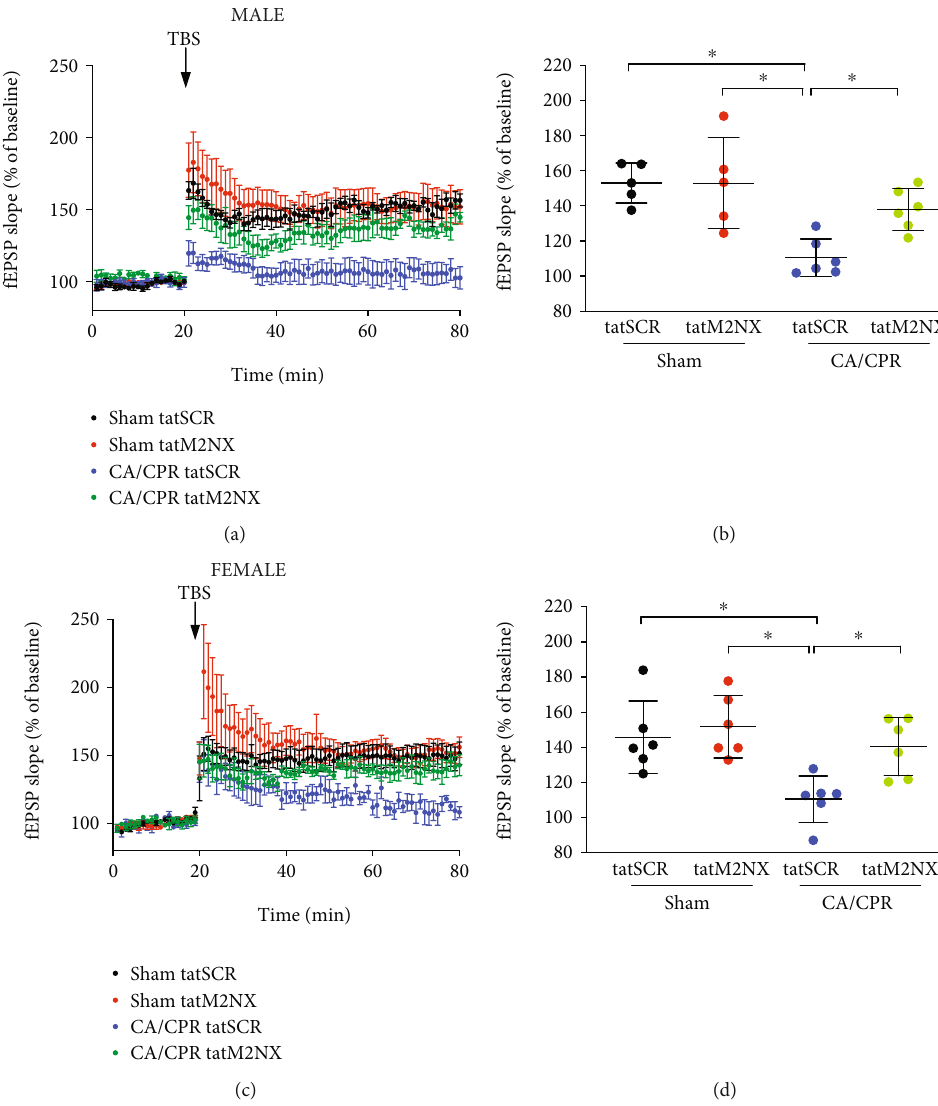
Figure 2: Acute inhibition of TRPM2 preserves LTP. (a) Time course of fEPSP slope from male juvenile mice 7 days after sham mice were administered 20mg/kg tatSCR (black) or tatM2NX (red) 30 minutes after CA/CPR and 7 days after CA/CPR mice were administered 20mg/kg tatSCR (blue) or tatM2NX (green) 30min after CA/CPR. (b) Quanti fi cation of change in fEPSP slope 60 minutes after TBS stimulation normalized to 20 minutes of baseline recording. (c) Time course of fEPSP slope from female juvenile mice 7 days after sham mice were administered 20 mg/kg tatSCR (black) or tatM2NX (red) 30 minutes after CA/CPR and 7 days after CA/CPR mice were administered 20mg/kg tatSCR (blue) or tatM2NX (green) 30 min after CA/CPR. (d) Quanti fi cation of change in fEPSP slope 60 minutes after TBS stimulation normalized to 20 minutes of baseline recording (set at 100%). Each point represents one hippocampal slice, with no more than 2 slices from an individual mouse. ∗ p < 0 : 05 by one-way